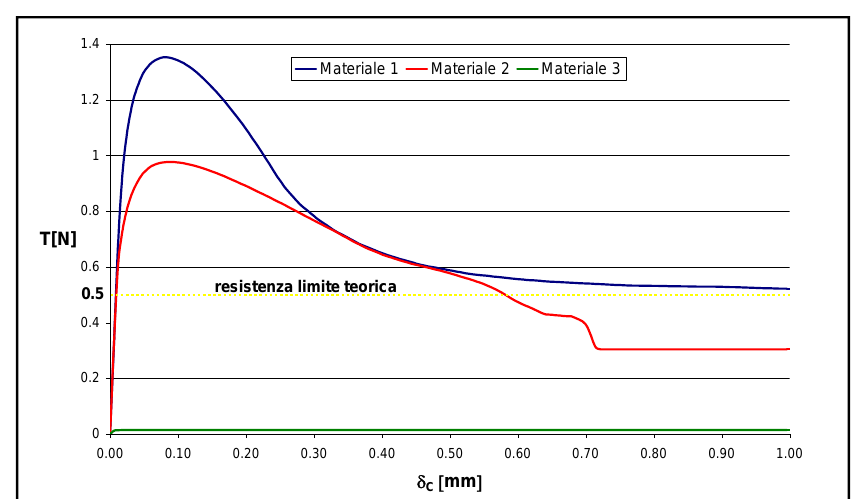
Figura 5: Forza orizzontale totale T in funzione della componente di spostamento  C .